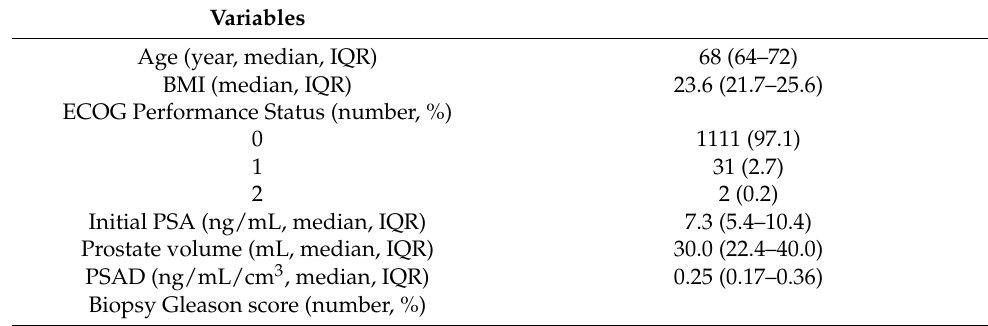
Table 1. Patient